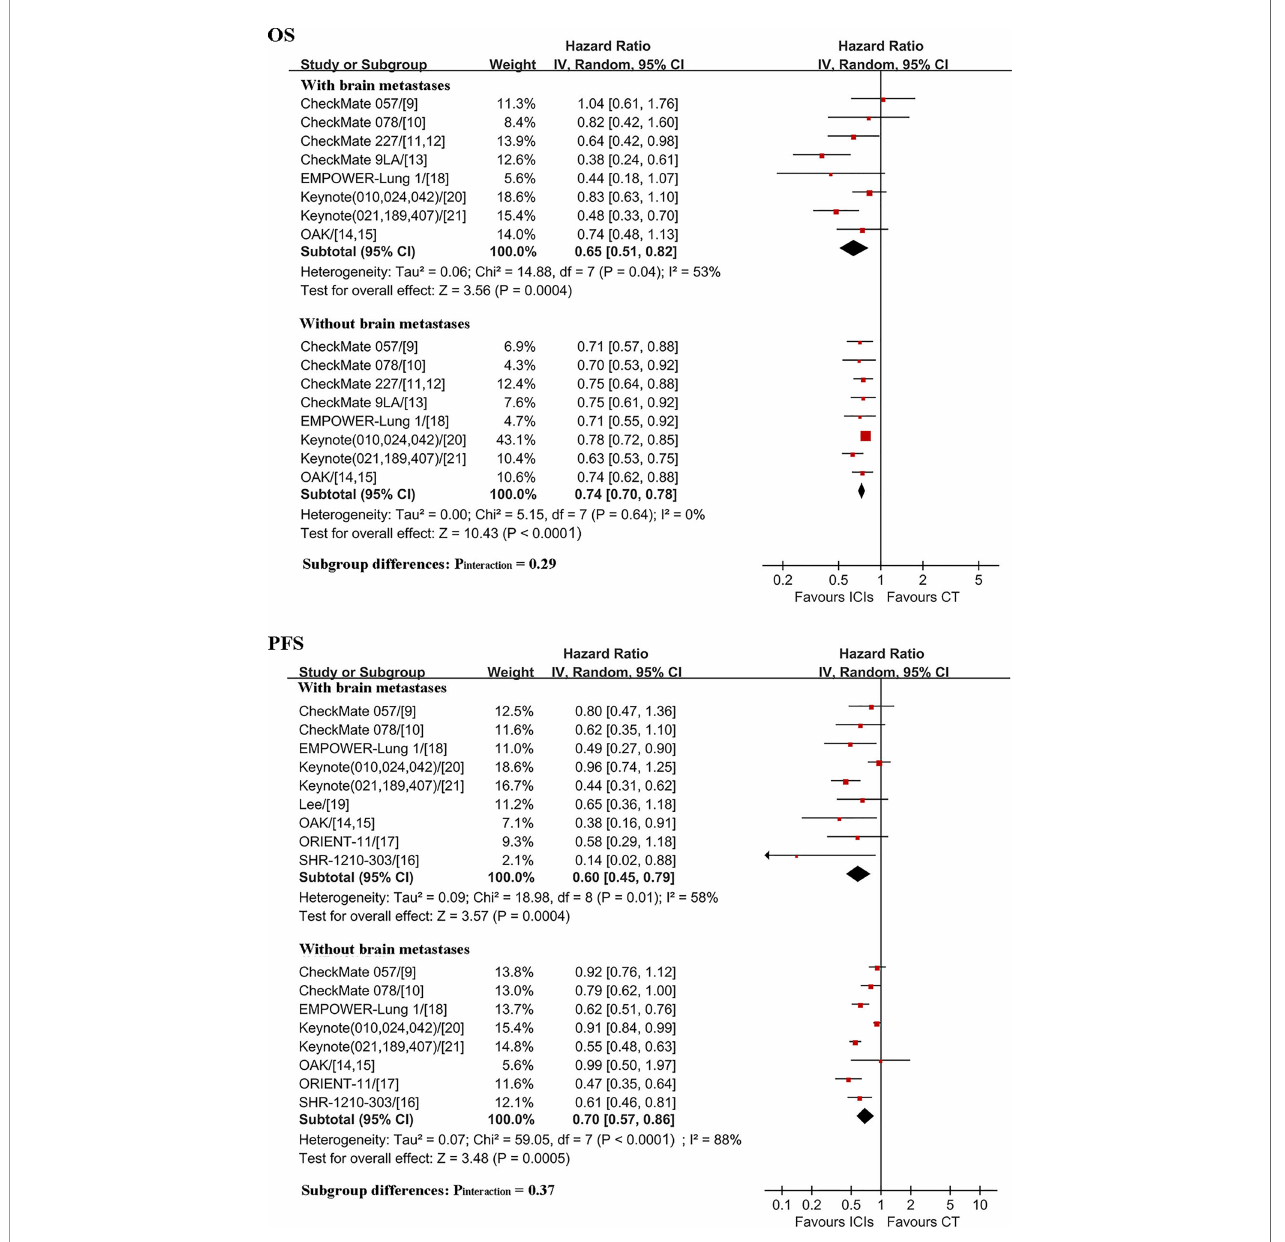
FIGURE 2 | Comparison of ICIs ef fi cacy between patients with and without brain metastases. OS, overall survival; PFS, progression-free survival; ICIs, immune checkpoint inhibitors; CT, chemotherapy; HR, hazard ratio; CI, con fi dence